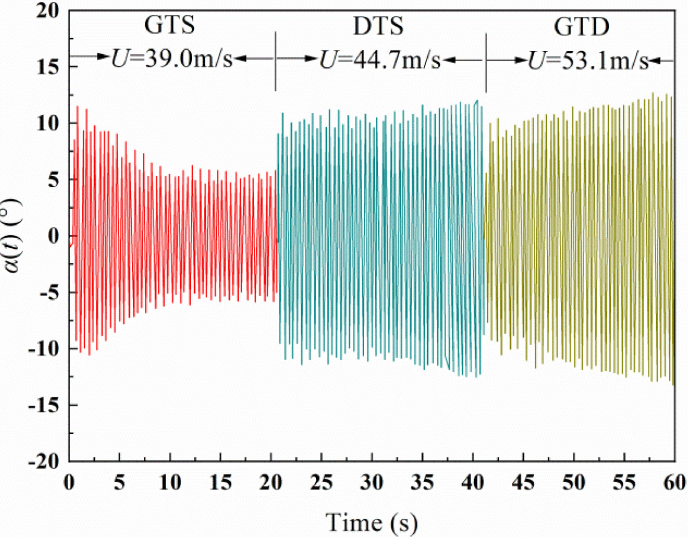
Figure 6. Soft flutter phenomenon of the big wind fairing section, +5 ◦ angle of